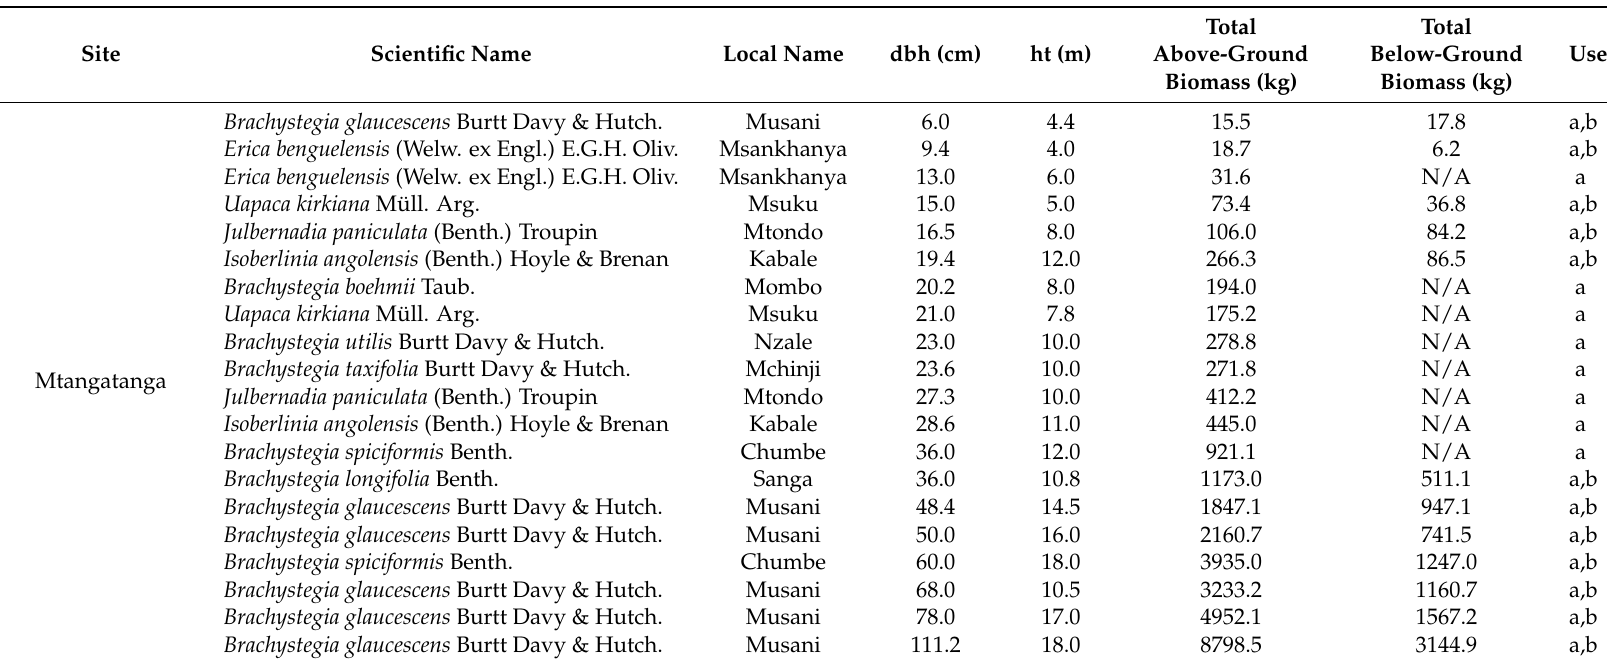
Table A1. Dataset used for model